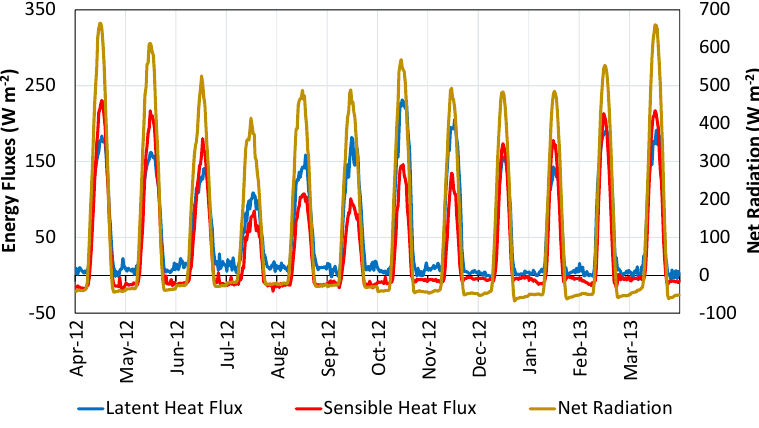
Figure 9. Annual variation of monthly mean diurnal variation of sensible heat and latent heat fluxes.